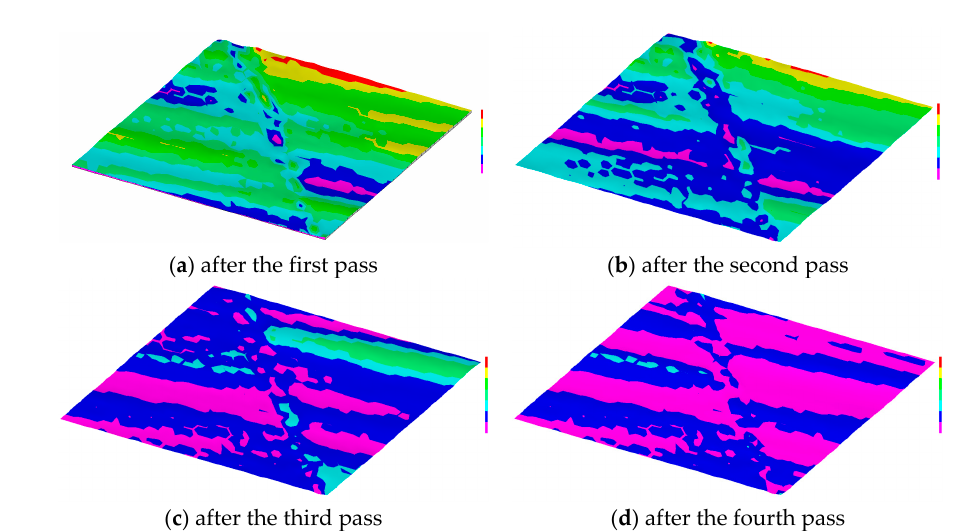
Figure 8. Grinding mechanism system.